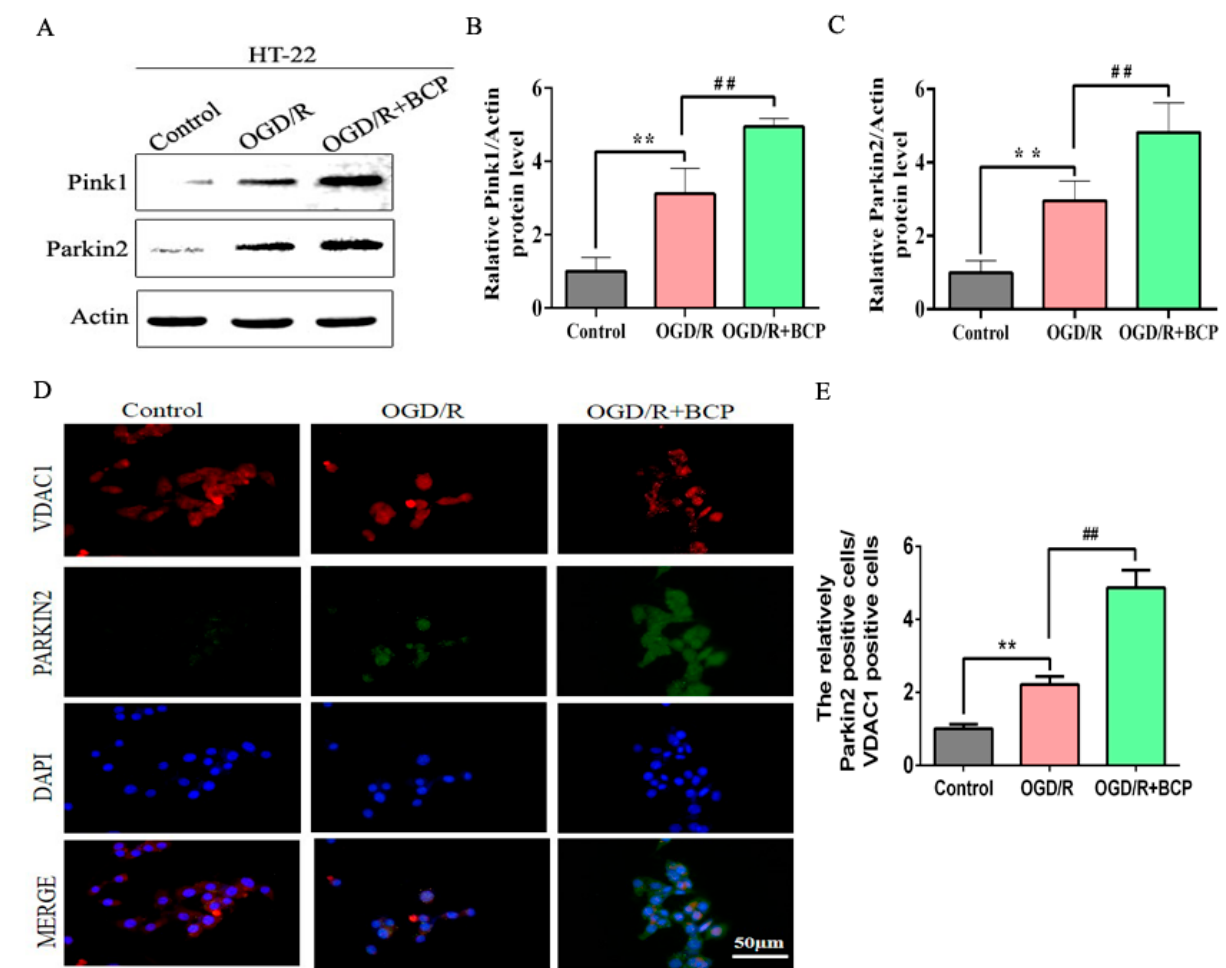
Figure 4. BCP activates the Pink1/Parkin2 pathway in OGD/R-injured HT-22 cells. ( A – C ) Represen- tative Western blots showing protein levels of Pink1 and Parkin2. Protein levels were normalized to β -actin. ( D , E ) Double-immunofluorescence staining for VDAC1 and Parkin2 in HT-22 cells at 24 h after reperfusion. VDAC1 (red) and Parkin2 (green) double-stained cells (yellow) indicate mi- tophagy. (Scale bar = 50 µ m, 400 × magnification). ( n = 3; ** p < 0.01 OGD/R group vs. control group; ## p < 0.01 OGD/R + BCP group vs. OGD/R